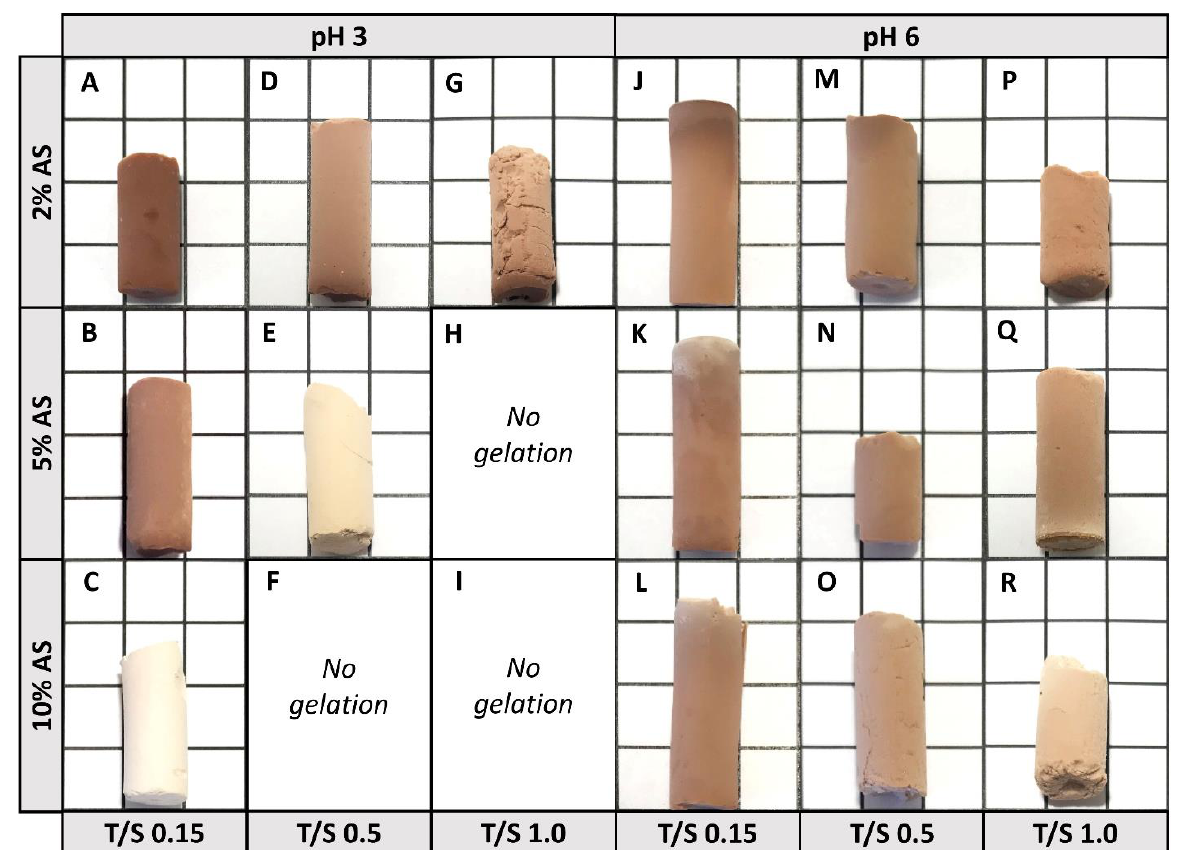
Figure 2. Photographs of the hybrid gels, illustrated on a 1 cm 2 grid, TS 0 . 15_3_2 ( A ), TS 0 . 15_3_5 ( B ), TS 0 . 15_3_10 ( C ), TS 0 . 5_3_2 ( D ), TS 0 . 5_3_5 ( E ), TS 0 . 5_3_10 ( F ), TS 1 . 0_3_2 ( G ), TS 1 . 0_3_5 ( H ), TS 1 . 0_3_10 ( I ), TS 0 . 15_6_2 ( J ), TS 0 . 15_6_5 ( K ), TS 0 . 15_6_10 ( L ), TS 0 . 5_6_2 ( M ), TS 0 . 5_6_5 ( N ), TS 0 . 5_6_10 ( O ), TS 1 . 0_6_2 ( P ), TS 1 . 0_6_5 ( Q ) and TS 1 . 0_6_10 ( R ).